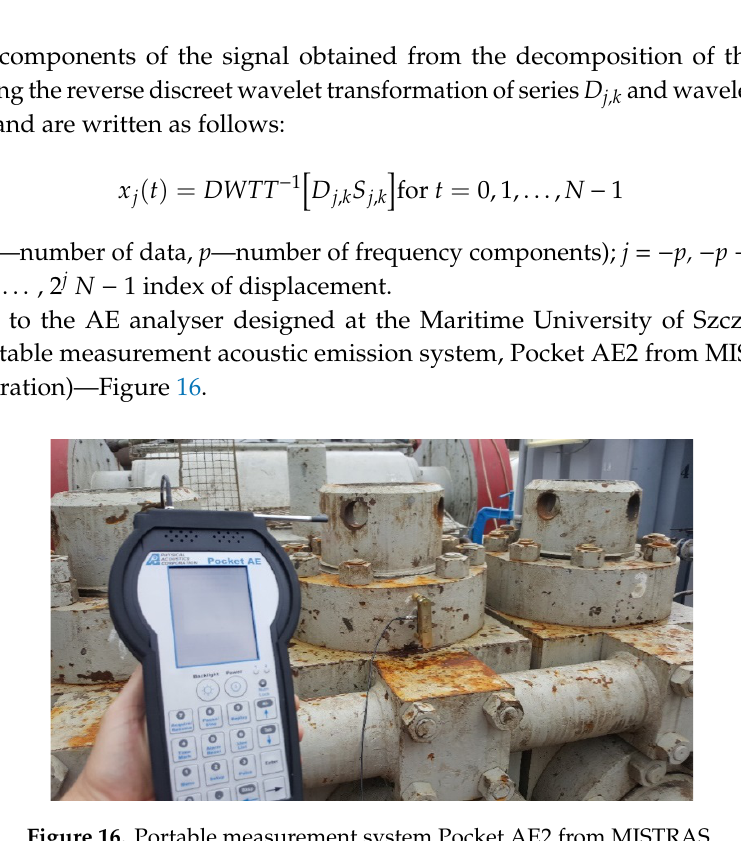
Figure 16. Portable measurement system Pocket AE2 from MISTRAS.